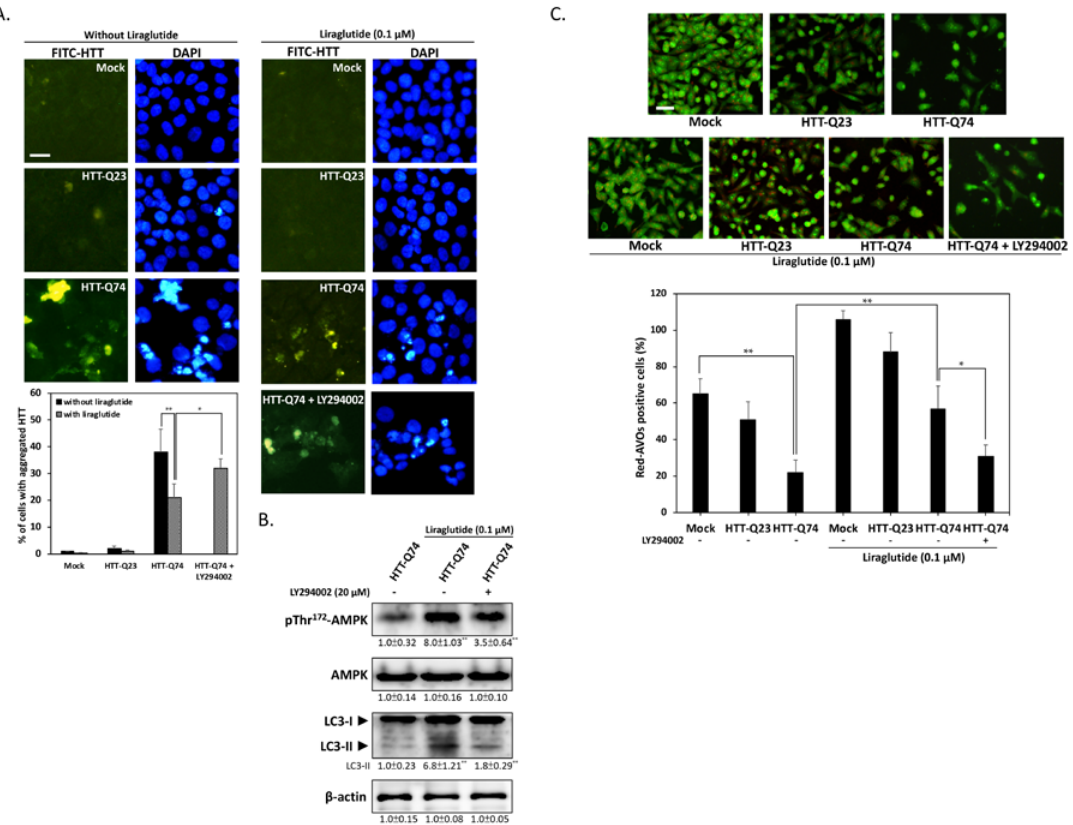
Figure 4. Liraglutide upregulates autophagy by activating AMPK and reducing HTT aggregation in HTT-Q74-overexpressed cells. ( A ) Immunofluorescence images showing that 48 h of HTT-Q74 overexpression increased the number of HTT aggregates. The percentage of cells contained HTT aggregates was calculated from five images of each treatment. Green: HTT, FITC, Blue: nuclei, DAPI; ( B ) Levels of p-AMPK/AMPK and LC3-I/II protein in HTT-Q74-overexpressing cells. Liraglutide markedly upregulated LC3-II and AMPK Thr 172 phosphorylation. This effect, however, was abolished by LY294002; ( C ) Representative images of AVO-positive cells treated through AO staining. The percentage of red-AVO positive cells was calculated from five images of each treatment. All data were collected from at least three independent experiments, and values are presented as mean ± SEM. The significance of differences was determined through multiple comparisons with Dunnett’s posthoc test for * p < 0.05 and ** p < 0.01 compared with mock groups. Scale bar represents 20 µ